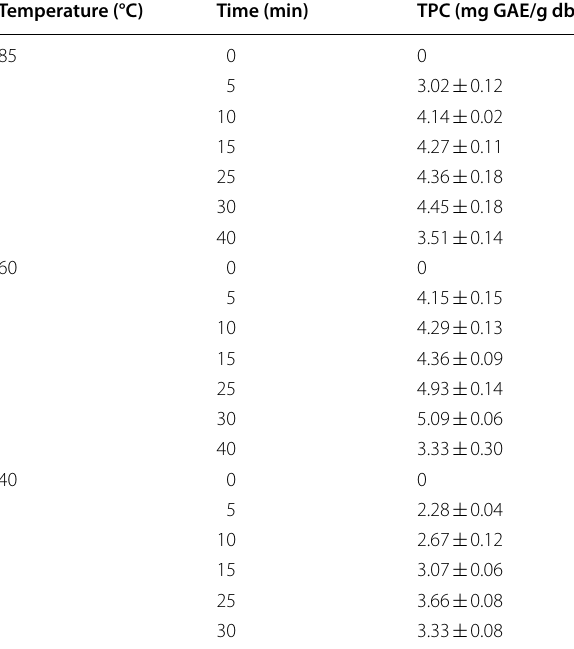
Table 1 Characterization results for waste apple pomace WAP characterization